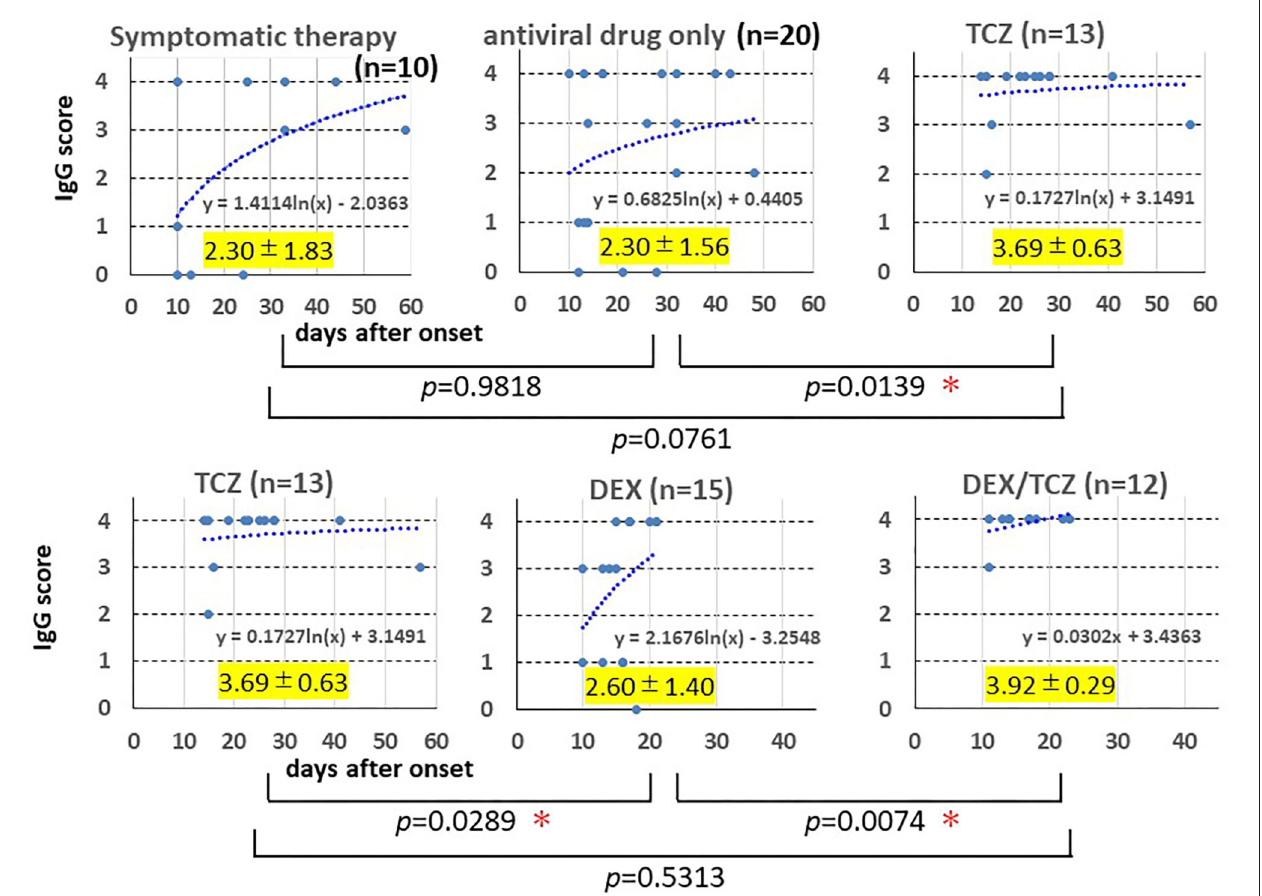
FIGURE 7 | Induction of IgG antibody for SARS-CoV-2. The sera were obtained from 10 patients with mild COVID-19 receiving symptomatic therapy, 20 patients with moderate COVID-19 receiving antiviral drug(s), 13 patients with severe to critical COVID-19 receiving antiviral drug(s) plus tocilizumab, 15 patients with severe COVID-19 receiving antiviral drug(s) plus dexamethasone, and 12 patients with severe COVID-19 receiving antiviral drug(s) plus dexamethasone followed by tocilizumab. The SARS-CoV-2 specific IgG antibody titer was measured by using the Corona Virus COVID-19 Antibody Rapid Detection Kit on blood samples collected several times in each patient after 10 days of the onset of illness. In patients who showed clearly detectable in detection kit (4 + ), the earliest sample was plotted on the graph, while in patients who did not show clearly detectable (4 + ), the last sample was plotted. The horizontal axis shows the day after onset, and the vertical axis shows the antibody scale for patients in the five treatment groups. The maximum value of antibody titer of each patient and the number of days from the onset of blood sampling date were graphed, and a logarithmic approximation curve was drawn. The highest antibody titers of each patient during the course were compared among the five treatment groups. *Statistically